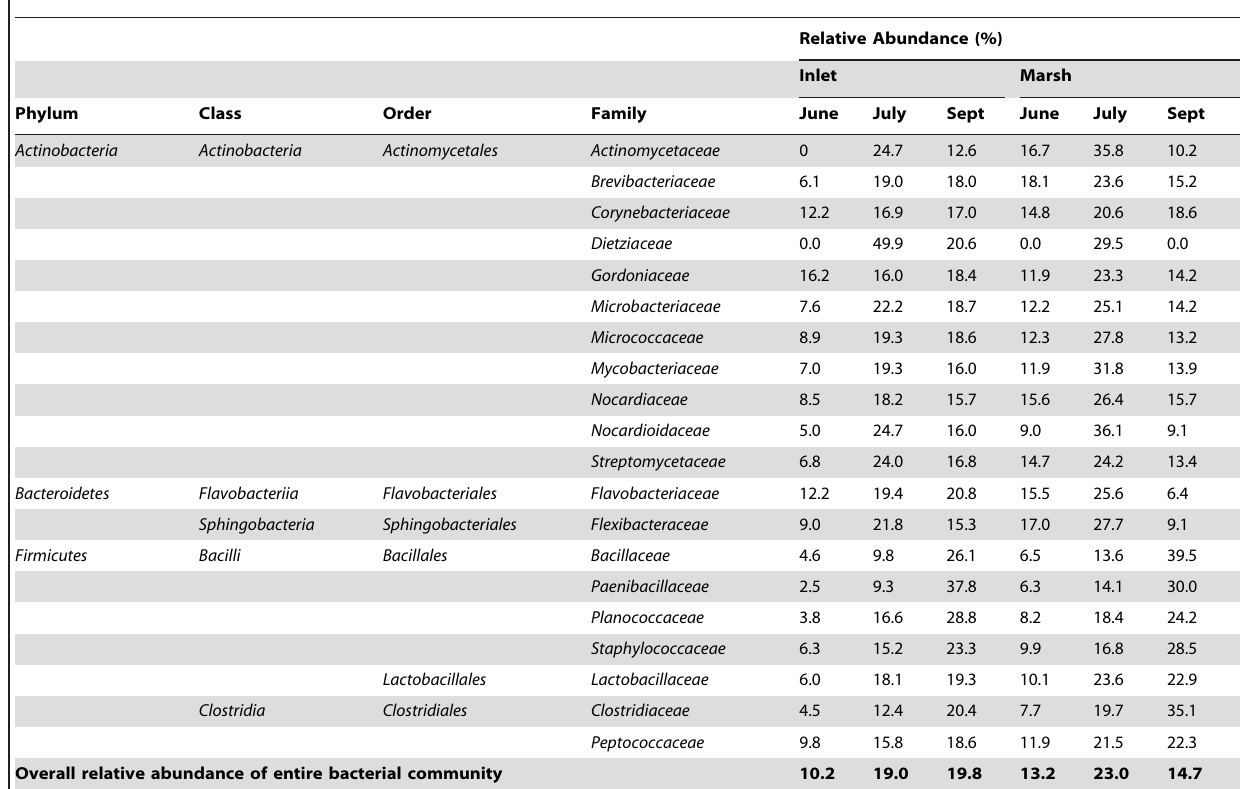
Table 4. Relative abundance (%) of families of Actinobacteria , Bacteroidetes , and Firmicutes known to contain hydrocarbon- degrading